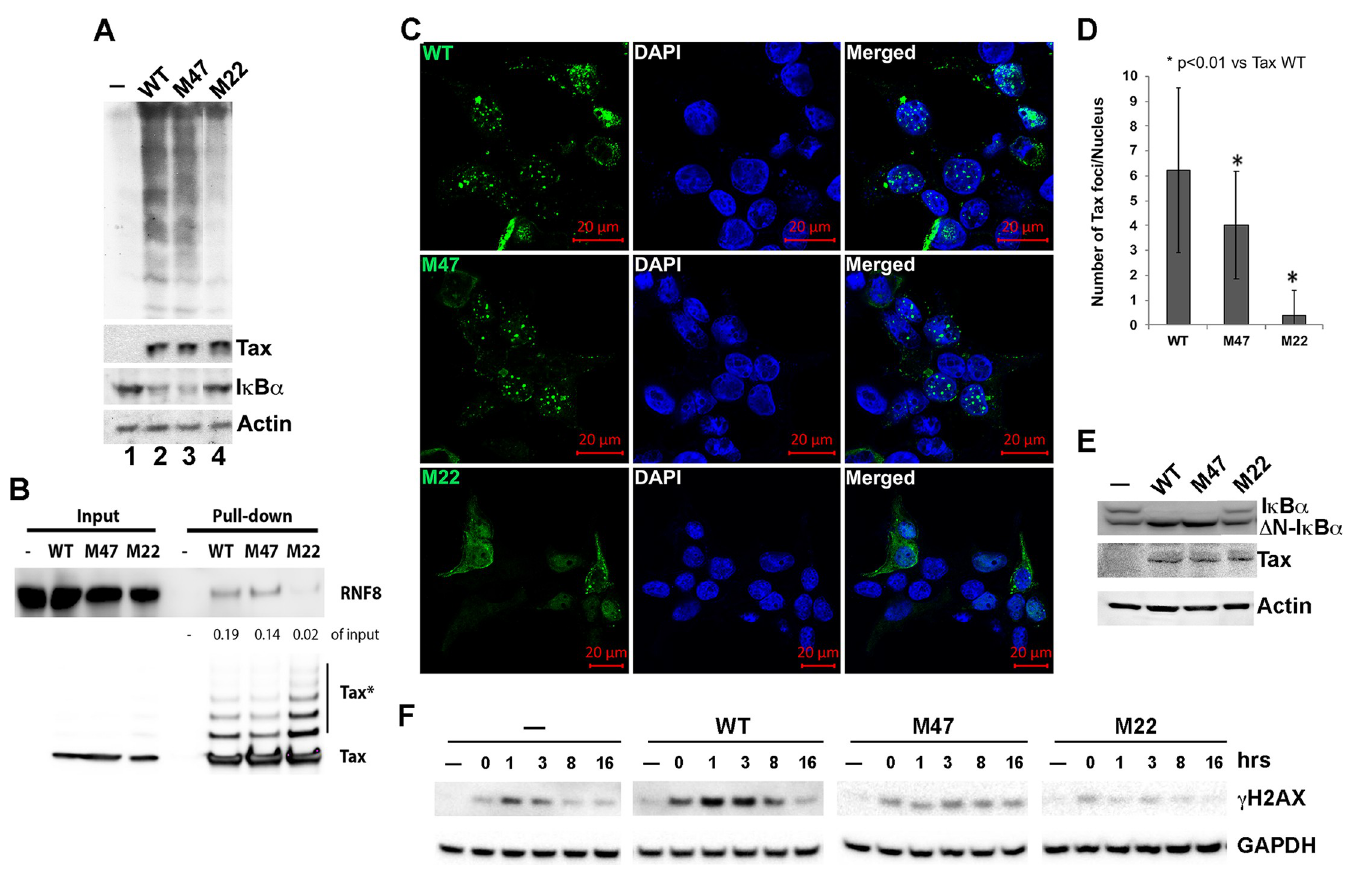
Fig 3. Aberrant RNF8 activation by Tax causes DDR impairment. (A) HeLa cells (10 5 ) were co-transfected for 48 hrs with HA-Ub and an expression plasmid for each of the tax alleles: 50 ng each for wildtype (WT) and M47, and 100 ng for M22, using lipofection (FugeneHD, Promega). Cells were harvested, lysed, and immunoblotted for HA, Tax, I κ B α and β -actin control (see Supplemental Information S4 Fig for quantitation of the polyubiquitin signals). (B) Derivation of the S-tagged Tax (WT) expression construct and S-tag pull-down using the RNase S-agarose beads had been previously described [15]. Constructs for Tax mutants: M47 and M22 were similarly derived. HEK 293T cells were transiently transfected with WT, M47 and M22 Tax alleles. Tax proteins in the respective whole cell lysates were enriched using the RNase S-agarose beads (Novagen) and analyzed by Western blotting using RNF8 and Tax antibodies. Pull-down RNF8 bands were quantified using Image J and normalized to the input RNF8 (left panel). Tax � denotes post-translationally modified forms Tax variants. The S-tagged Tax was released from the beads using a large excess of S peptide and immunoblotted for Tax and RNF8 as indicated. (C) Immunofluorescence of Tax (green), nuclei (blue, DAPI), and merged images were performed as in Fig 2 at 48 hrs post-transfection of the respective tax alleles (upper left corners of panels in the left column) into 293 cells. (D) The number of Tax foci (i.e.,TSS) per nucleus induced by WT, M47 and M22 alleles were calculated after counting nuclear speckles of 56 transfected cells each. (E) Immunoblots (I κ B α Tax, and β -actin) of HeLa-G: Δ N-I κ B α stably expressing WT, M47 and M22 tax alleles respectively. (F) HeLa-G: Δ N-I κ B α :WT,M47 and M22 were treated with bleomycin as in Fig 1. DDR repression caused by the respective Tax alleles was determined by monitoring γ H2AX levels over a 16-hr period post bleomycin treatment (see supplemental information S5 Fig for